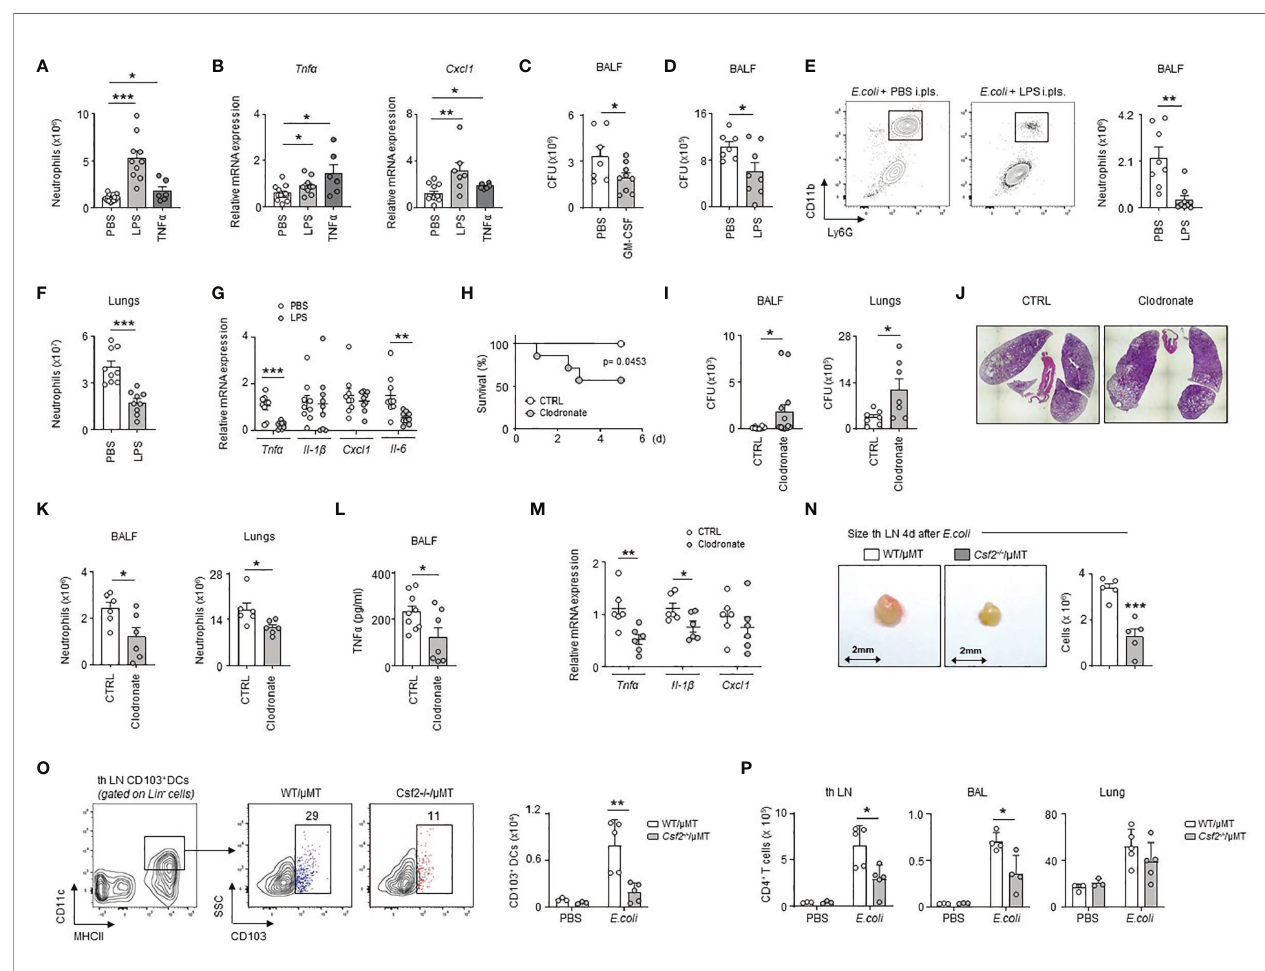
FIGURE 6 | PS cells enhance lung immunity upon bacterial airway infection. (A, B) Enumeration of neutrophils (A) and relative mRNA expression of Tnf a and Cxcl1 (B) in lungs 24h after i.pls. injection of PBS, 20µg of LPS or 100ng of TNF a (n=6-14 mice). (C) Number of CFU in BALF 6h after i.t. E. coli infection with (grey) or without (white) concomitant i.pls. injection of GM-CSF (n=7-9). (D – G) Mice were sacri fi ced 6h after i.t. E. coli infection with (grey) or without (white) concomitant i.pls. injection of LPS. (D) Number of CFU in BALF (n=9). (E, F) Enumeration of neutrophils in BALF (E) and lungs (F) (n=9). (G) Relative mRNA expression of Tnf a , Il-1 b , Cxcl1 and Il-6 in lungs (n=8-9 mice). ( H – M ) Mice received i.pls. injection of liposome control (white) or clodronate (grey) and 2 days later they were intra-tracheally infected by E. coli (5x10 6 CFU) during 5 days (H) or 24h (I – M) . (H) Survival curve (n=7-8 mice/group). Data were analyzed by Log-rank (Mantel-Cox) test. (I) Number of CFU in BALF (n=12 mice) and lungs (n=7 mice) 24h post-infection. (J) Representative hematoxylin and eosin staining in lung sections 24h post-infection (n=4 mice). (K) Enumeration of neutrophils in BALF and lungs 24h post-infection (n=6 mice). (L) TNF a level in BALF 24h post-infection (n=7-9 mice). (M) Relative mRNA level expression of Tnf a , Il-1 b , Cxcl1 in lungs 24h post-infection (n=6 mice). ( N ) Enumeration of cells in tracheobronchial lymph node of chimeric WT/µMT and Csf2 -/- / µMT mice 4 days after i.t. E. coli infection (n=5). (O) Gating strategy and enumeration of CD103 + DCs in tracheobronchial lymph node of chimeric WT/µMT and Csf2 -/- /µMT mice 4 days after i.t. E. coli infection (n=3-5). (P) Enumeration of CD4 + T cells in tracheobronchial lymph node, BAL and lung of chimeric WT/µMT and Csf2 -/- /µMT mice 4 days after i.t. E. coli infection (n=3-5). (B, G, M) The expression level was arbitrarily set to 1 for one sample from the PBS/CTRL group, and the values for the other samples were calculated relatively to this reference. Data are pooled data from at least 2 independents experiments. Data represent mean ± S.E.M. and were analyzed by the two-tailed unpaired t-test. *p<0.05; **p<0.01;